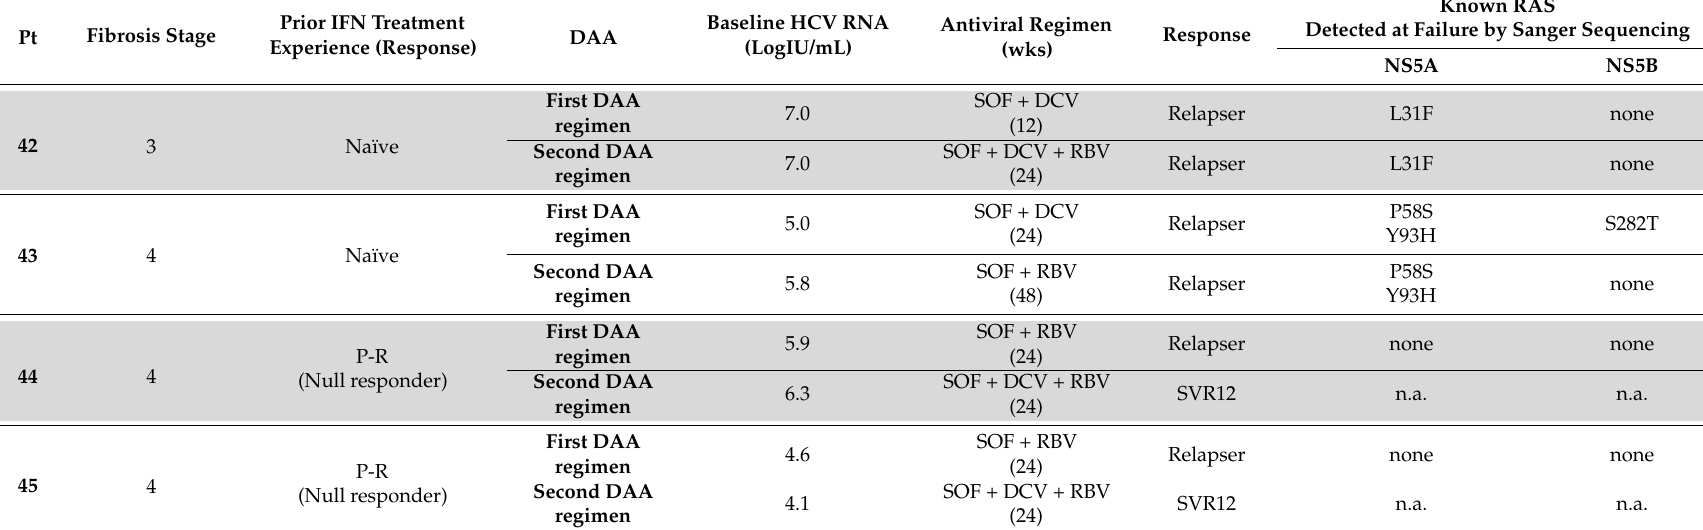
Table 2. Characteristics of HCV genotype (GT)3a patients who failed DAA treatment and their drug resistance-associated substitutions detected by Sanger sequencing.